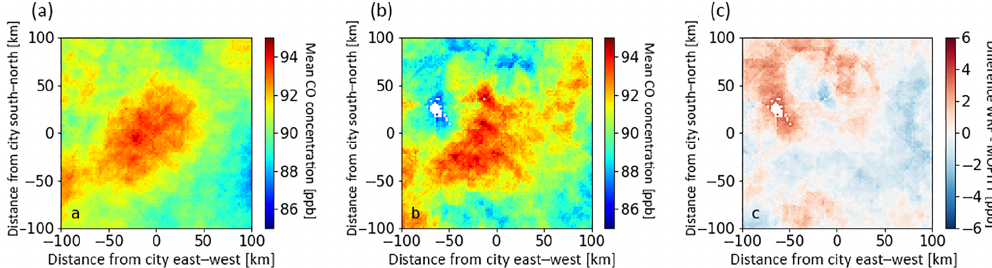
Figure 10. As Fig. 6 for 2006: (a) only background optimization, (b) MOPITT V6 signal, (c) difference WRF-MOPITT after background op- timization, (d) WRF after background and emission optimization. (e) As (b) . (f) As (c) but now after background and emission optimization. The optimum emission is found to be 0.83 times the original emission.